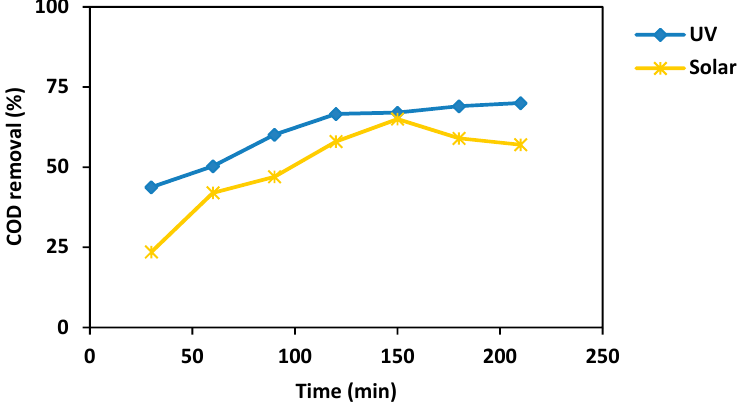
Figure 7. Influence of incident irradiance on COD removal over the 3.5-h duration test (process conditions: pH—4, UV light irradiation—64 W, catalyst dose—500 mg/L).